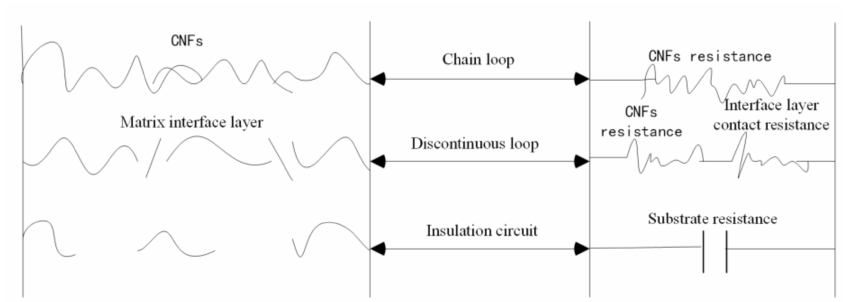
Figure 3. CNFPUC composite equivalent circuit for different CNF